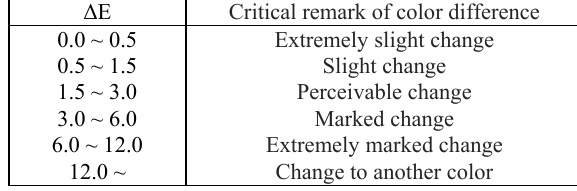
Table 1 . National Bureau of Standards NBS system of expressing color differences.